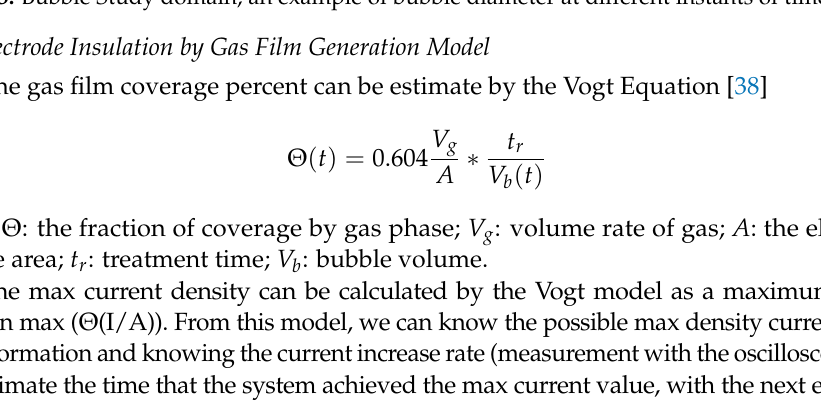
Figure 3. Bubble Study domain, an example of bubble diameter at different instants of